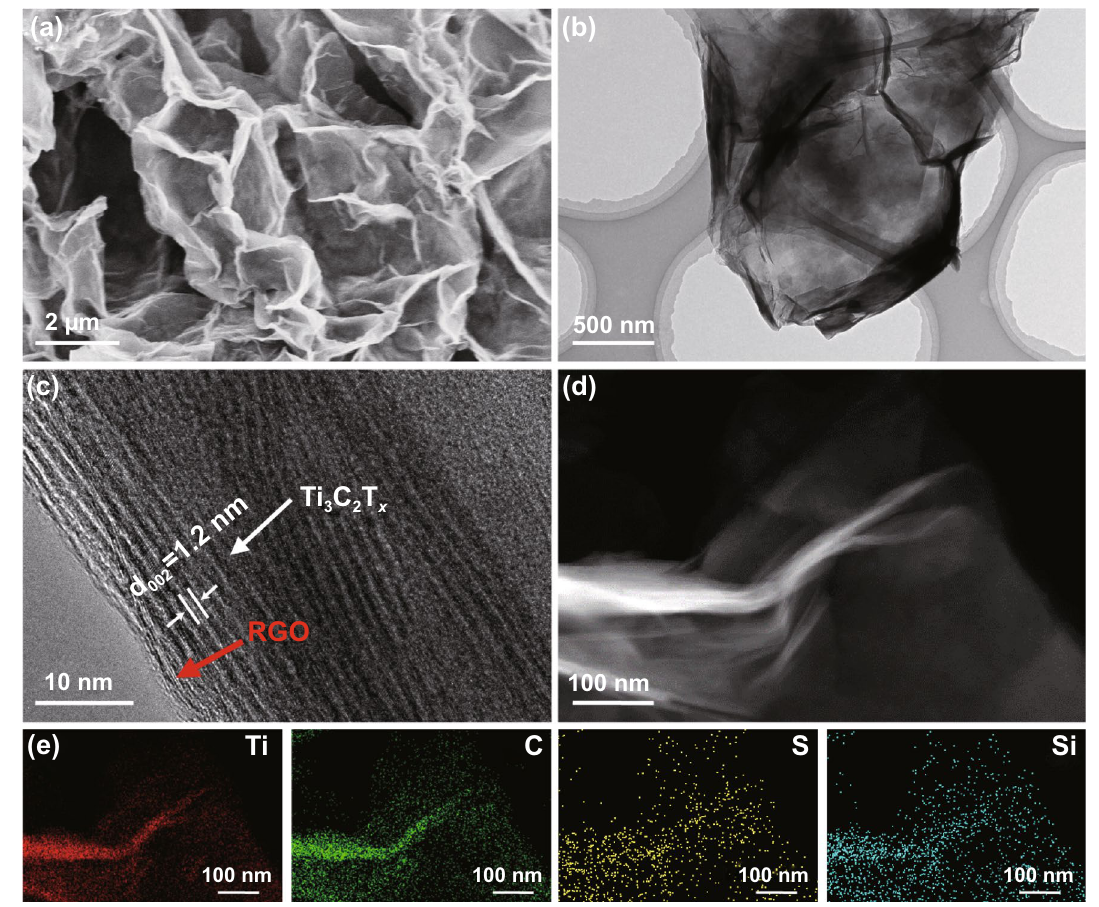
Fig. 3 a SEM image, b – c TEM images, d high-angle annular dark-field image with e the corresponding EDS mapping of